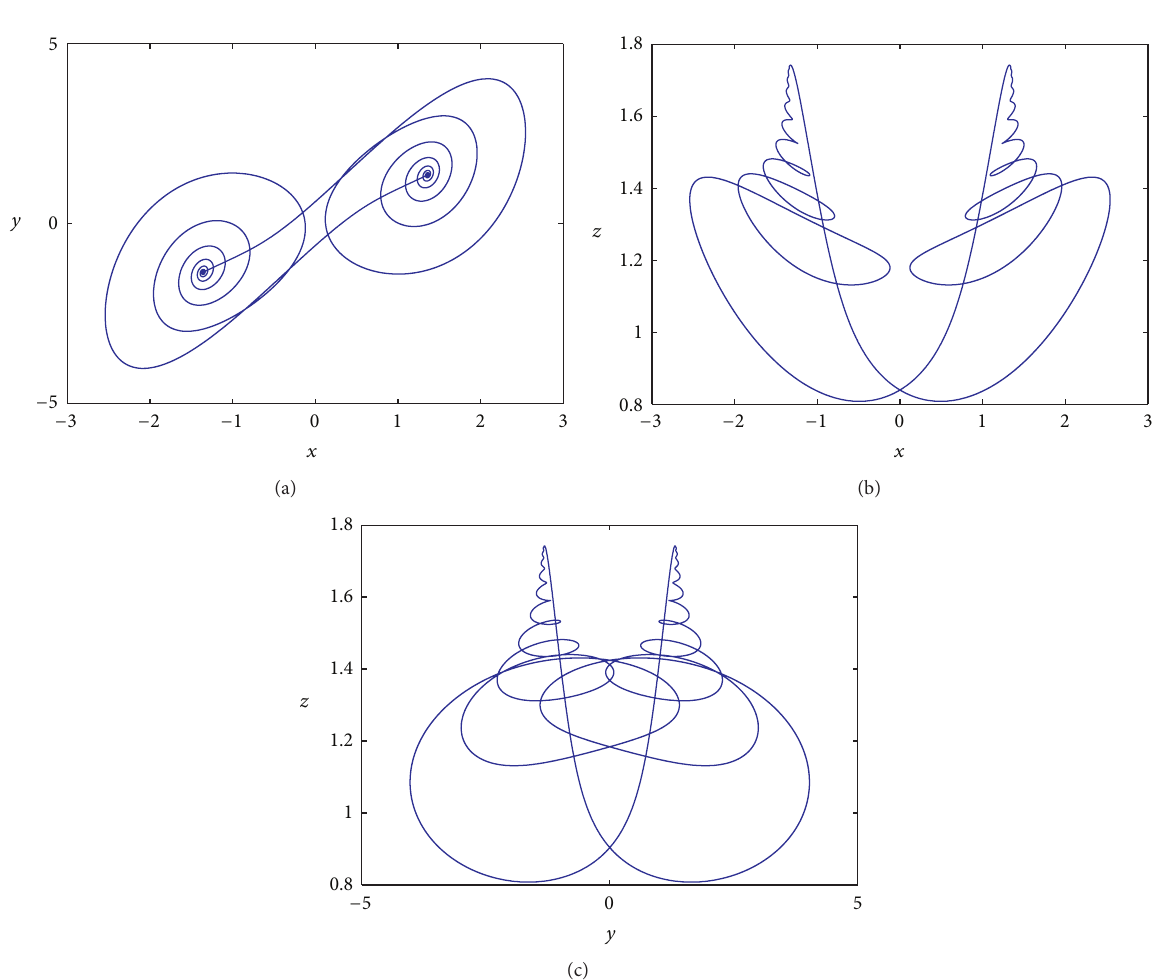
Figure 3: Phase portraits of the system (6) with 𝐴 = 1 , 𝜔 = 0.6 , 𝑎 = 10 , and 𝛾 = 100 : (a) 𝑥 - 𝑦 plane; (b) 𝑥 - 𝑧 plane; (c) 𝑦 - 𝑧 plane.